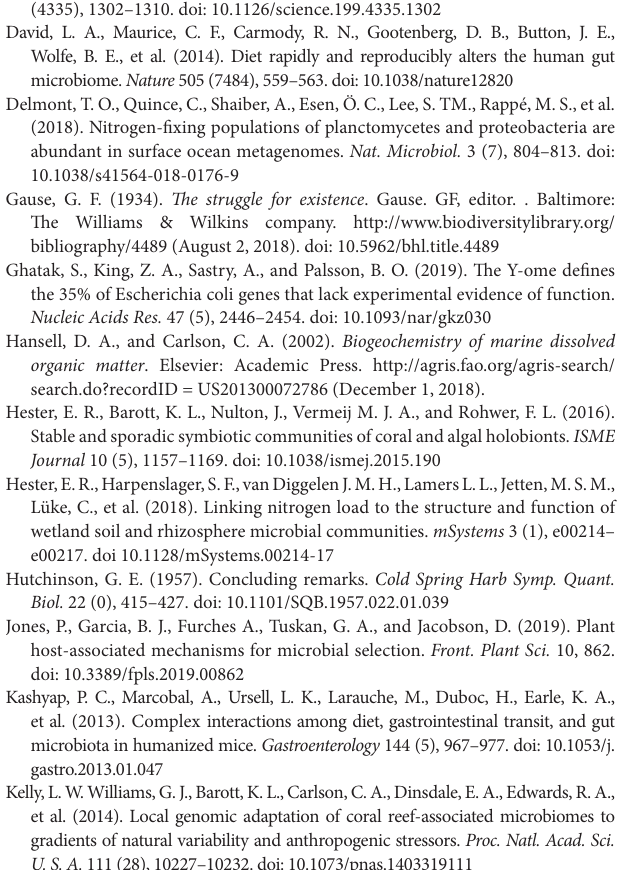
SUPPLEMENTAL TABLE 6 | Dunn multiple comparisons evaluating the cofactors metabolism subsystem. SUPPLEMENTAL TABLE 7 | Dunn multiple comparisons evaluating the fatty acids metabolism